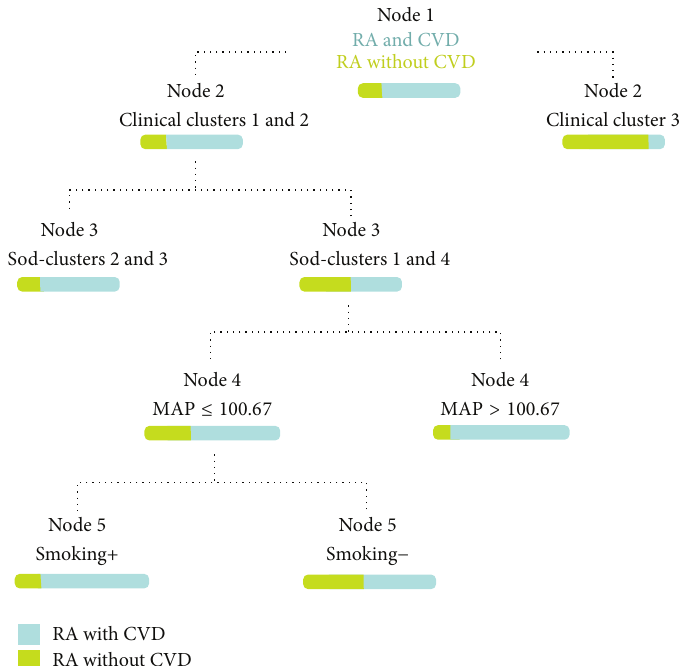
Figure 1: CART predictive model: the main predictive factors significantly associated with the development of CVD in RA are clinical and sociodemographic cluster, mean arterial pressure (MAP), and current smoking, with variable importance scores higher than 0.73.